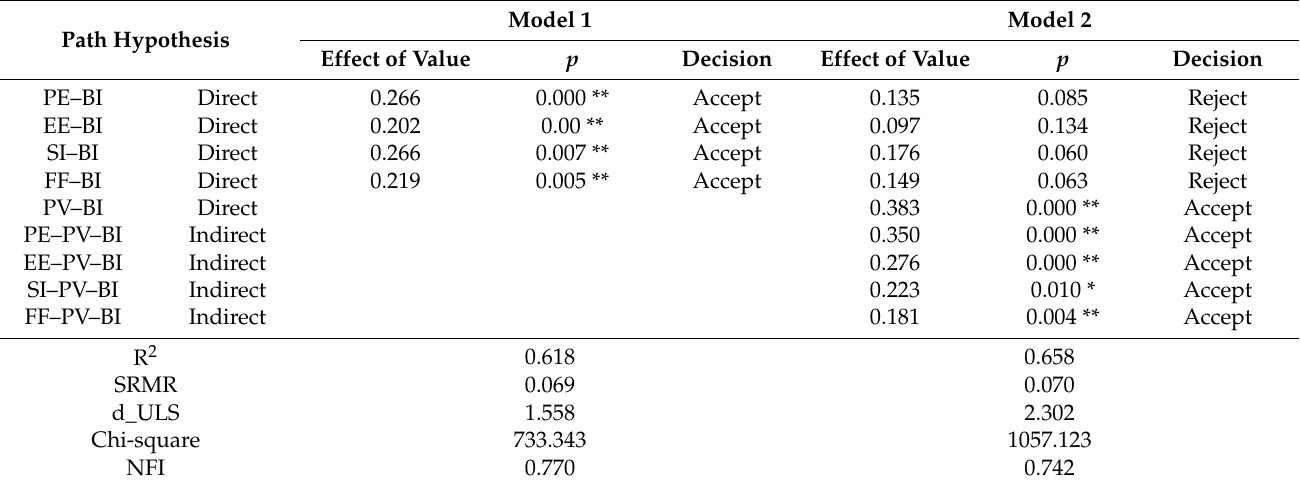
Table 5. Model path test comparison.